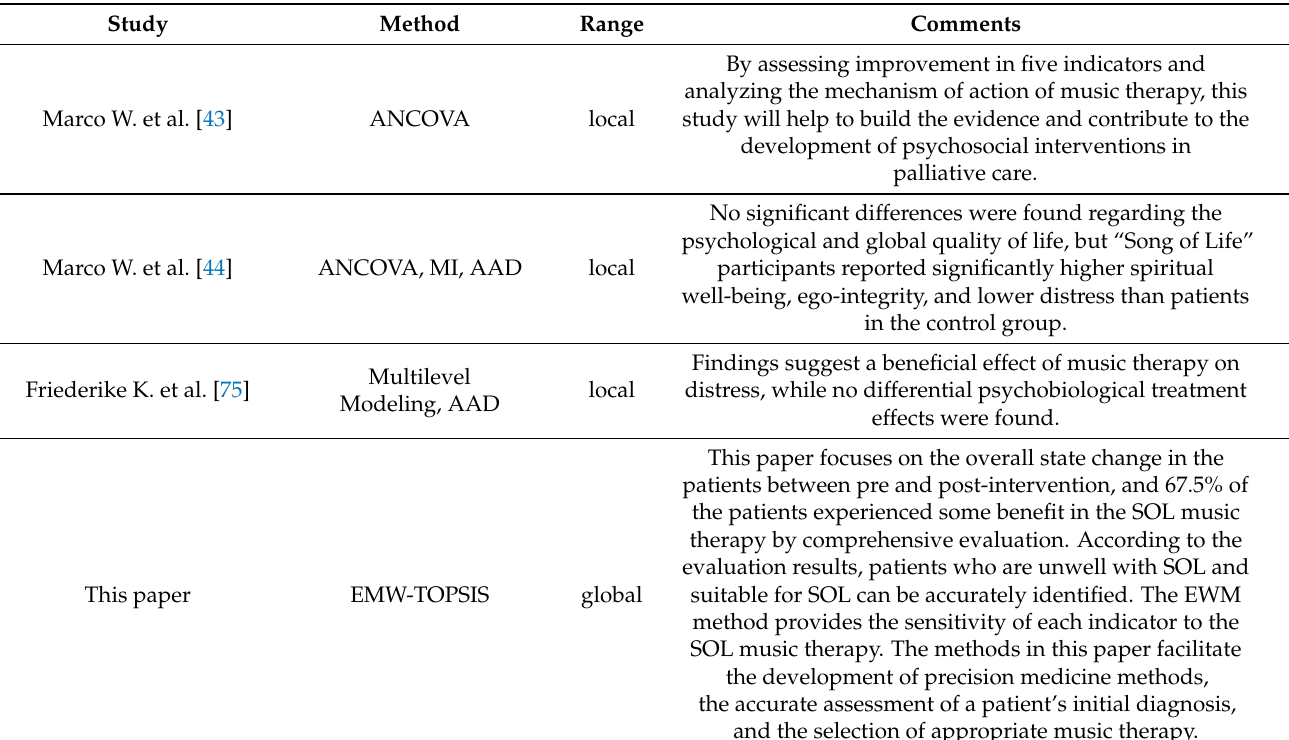
Table 10. A comparative analysis table for the study on SOL music